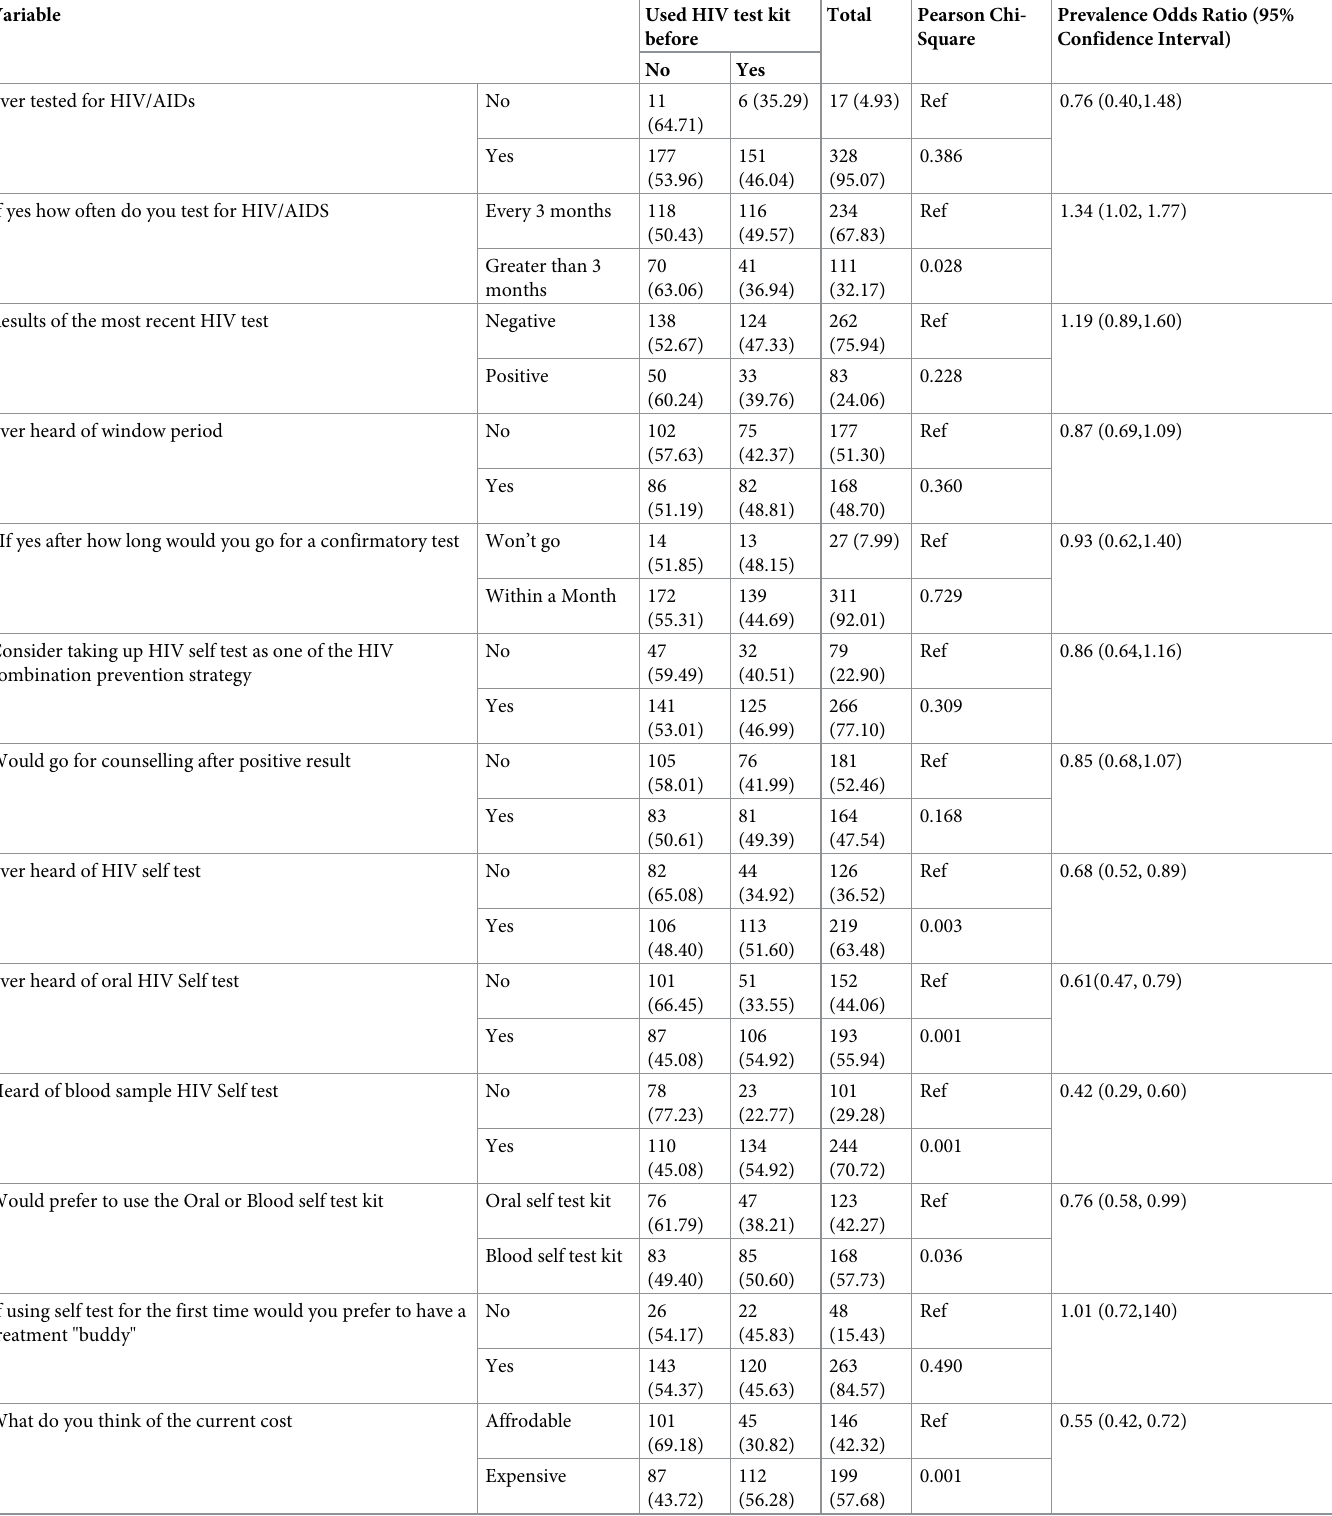
Table 3. HIV self-testing acceptability, uptake & associated